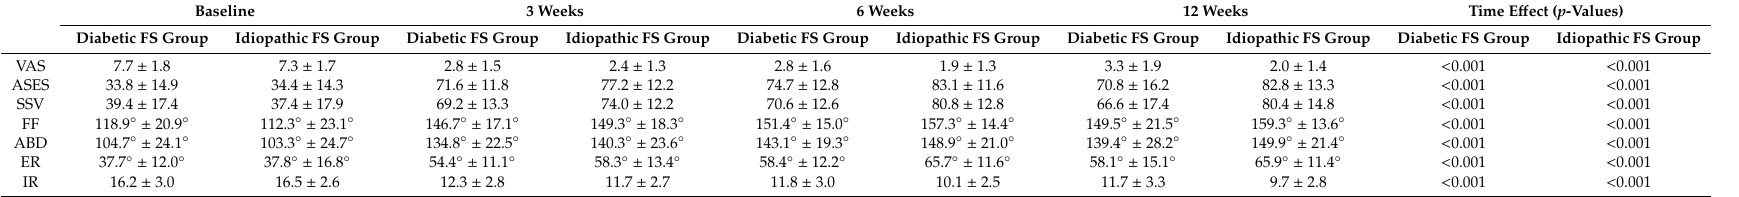
Table 2. Serial changes in outcome measurements for patients with diabetic or idiopathic